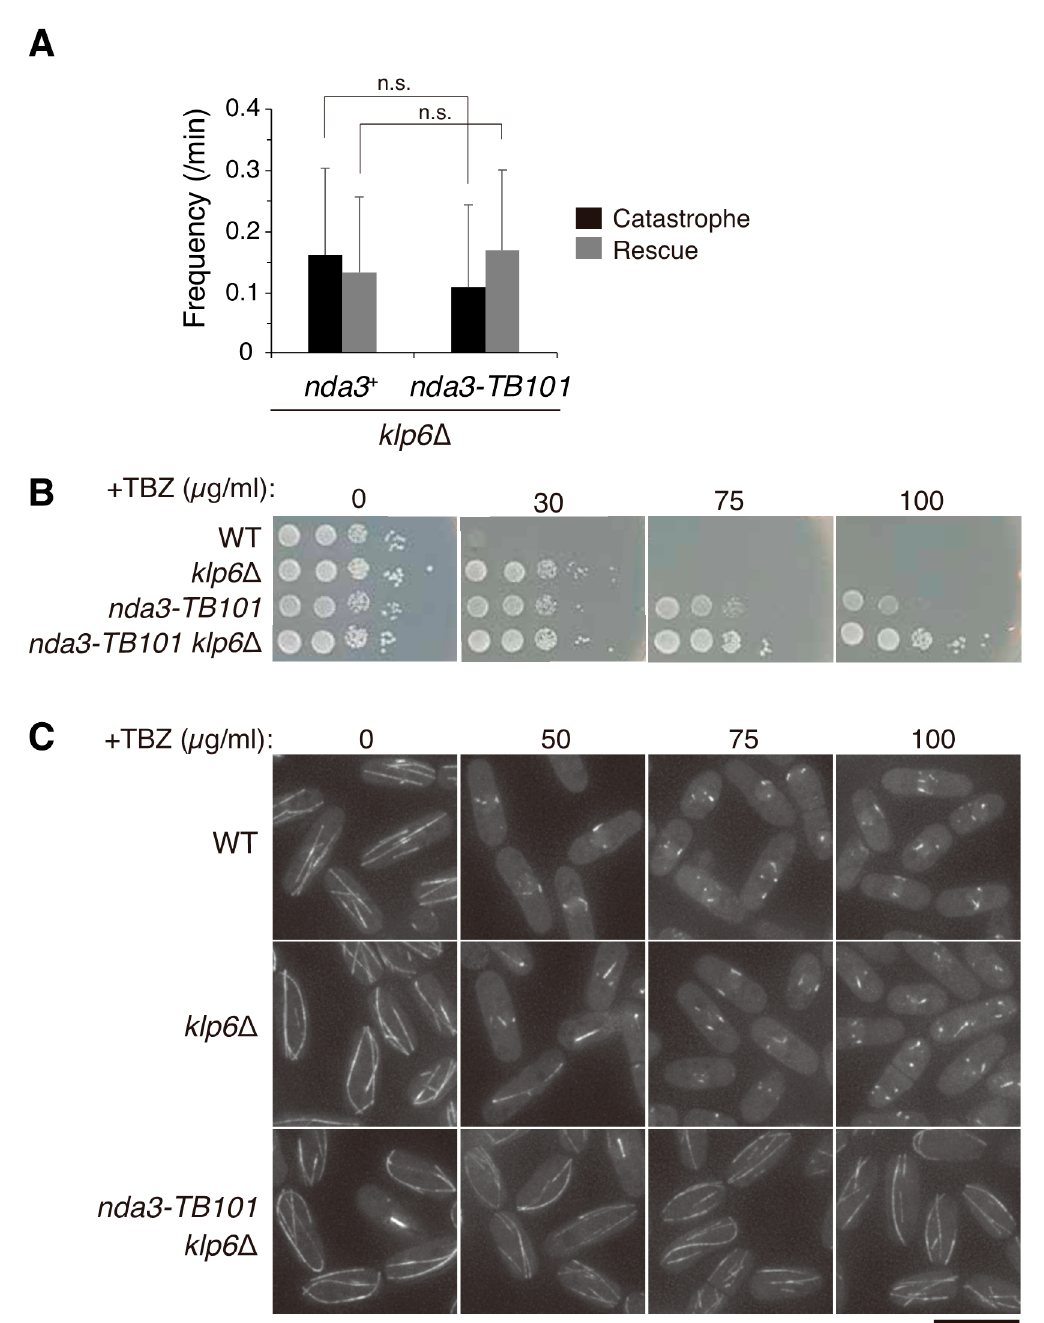
Figure 8. Microtubules are differently stabilized in the mutants of kinesin-8 and nda3-TB101 . ( A ) Frequencies of catastrophe and rescue of microtubules in the indicated strains. The nda3 + gene (WT), n = 21 bundles; nda3-TB101 gene, n = 20. Not significant, n.s. (Student’s t -test). ( B ) Ten-fold serial dilutions of cells with indicated genotypes in rich media without (0) or with TBZ at indicated concentrations (30–100 µ g/mL). Incubated at 30 ◦ C for 3 days. ( C ) Microtubules were monitored in cells expressing GFP-Atb2 in the indicated genotypes at each concentration of TBZ (0–100 µ g/mL). Scale bar, 10 µ